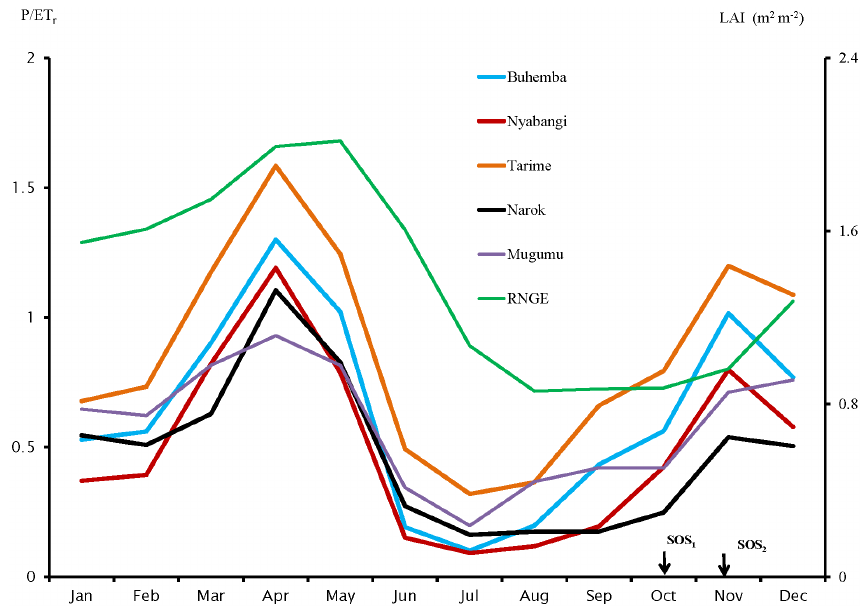
Figure 2. The moisture index (SMI) derived from historical precipitation observations ( P ) across the Mara Basin and the global reference evapotranspiration data of Trabucco and Zomer (2009) (ET r ) . The dotted line represents the leaf area index (LAI) for the savanna ecosystem. SOS 1 and SOS 2 represent the start of the wet season (SOS) transition months to trigger growth. Table 1. Summary of the inputs of the SWAT model and the evaluation datasets. Spatial/temporal Source Description resolution Rainfall 5km/1-day Roy et al. (2017) Bias-corrected satellite rainfall for Mara